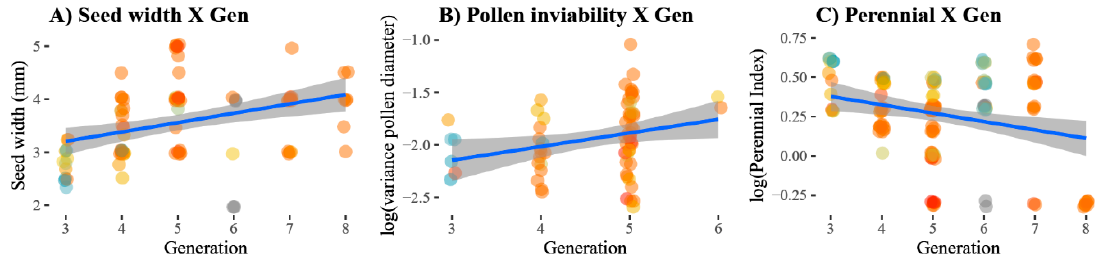
Figure 3. Over generations of intermating ( A ) selection for increased seed size shows progress, ( B ) infertility is highly variable but increasing, and ( C ) perenniality segregates in later generations with a trend toward perenniality loss. Points are colored by maternal line. For breeding purposes, the outliers (individuals that are increasing in perenniality) are very important to balance the need for increased seed production with strong regrowth capacity. There is also a need to prevent new cultivars from becoming invasive.